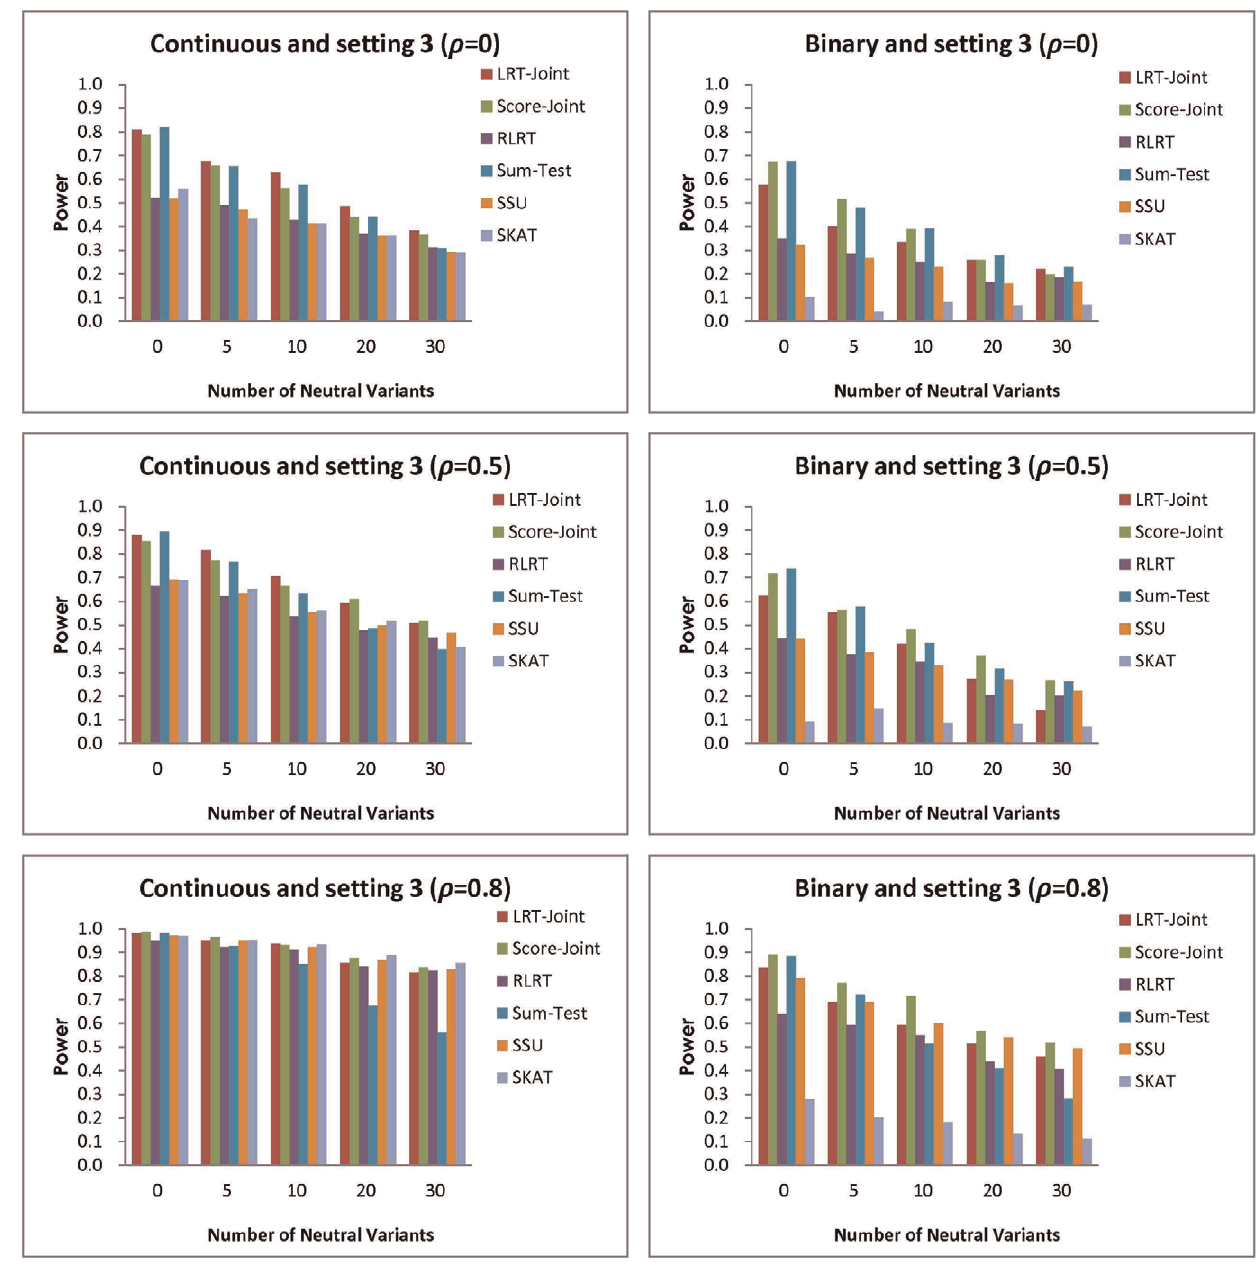
Figure 5. Simulation setting 3: b k ~ ( 0 : 4 , 0 : 4 , 0 : 35 , 0 : 35 , 0 : 3 , 0 : 3 , 0 : 2 , 0 : 2 , 0 : 1 , 0 : 1 ) T ( continuous trait ) ; OR ~ ( 2 , 2 , 1 : 8 , 1 : 8 , 1 : 6 , 1 : 6 , 1 : 4 , 1 : 4 , 1 : 2 , 1 : 2 ) T ( binary trait ) .